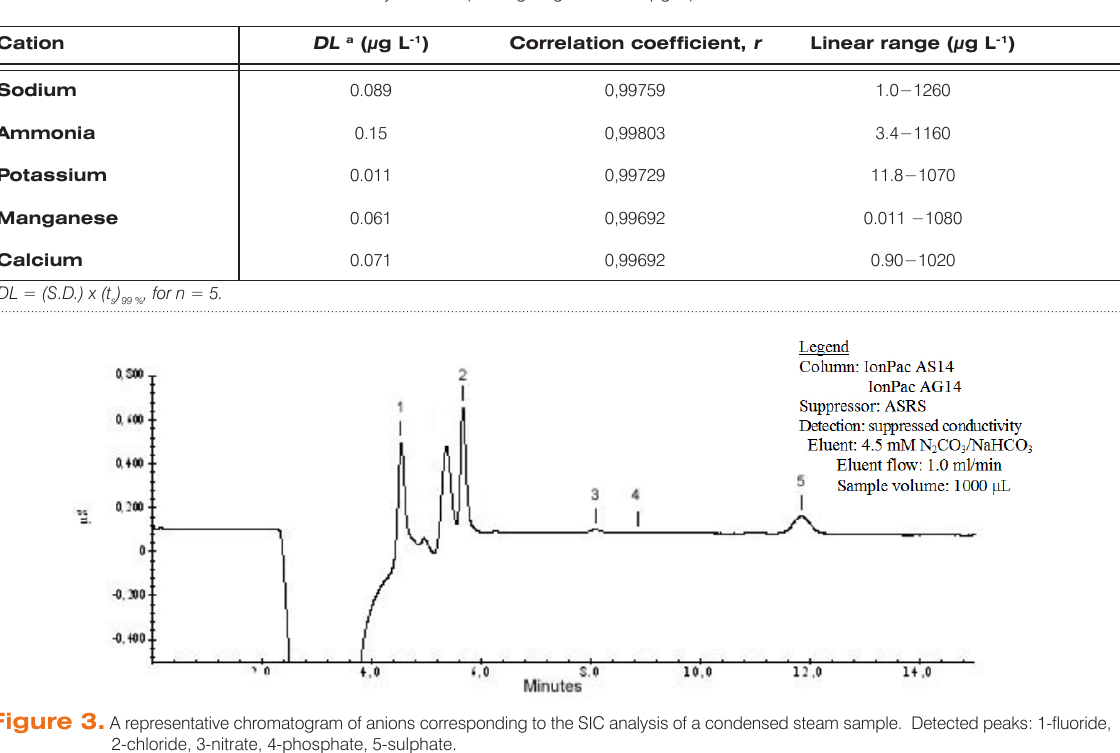
Table 4. Detection limits obtained for the five analyte cations (working range 1.0−1000 µg L -1 ).